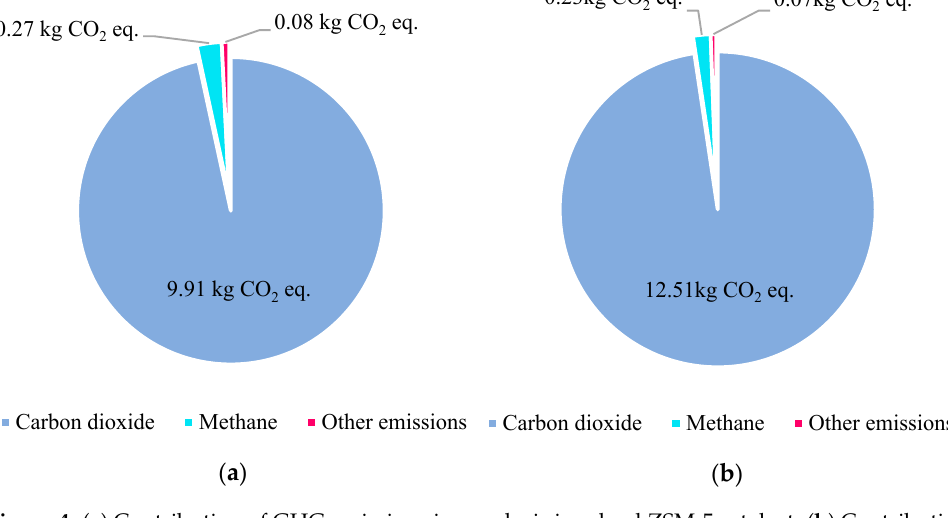
Figure 4a.Contribution of ( a ) Figure 4. ( a ) Contribution of GHG emissions in pyrolysis involved ZSM-5 catalyst. ( b ) Contribution of GHG emissions in pyrolysis involved zeolite Y Figure 4b. Contribution of GHG emissions in pyrolysis i ()